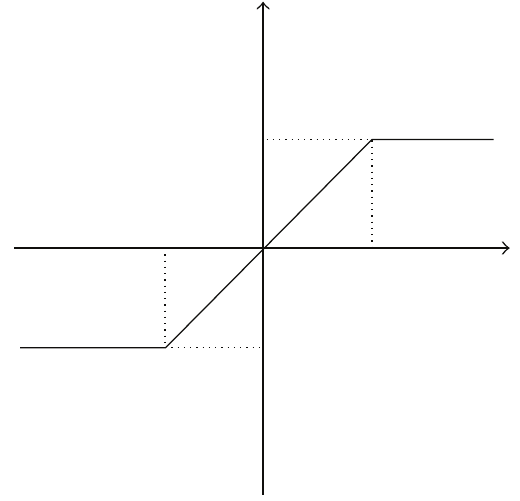
Figure 1: A saturation function Sat (𝑢 𝑖 (𝑡))